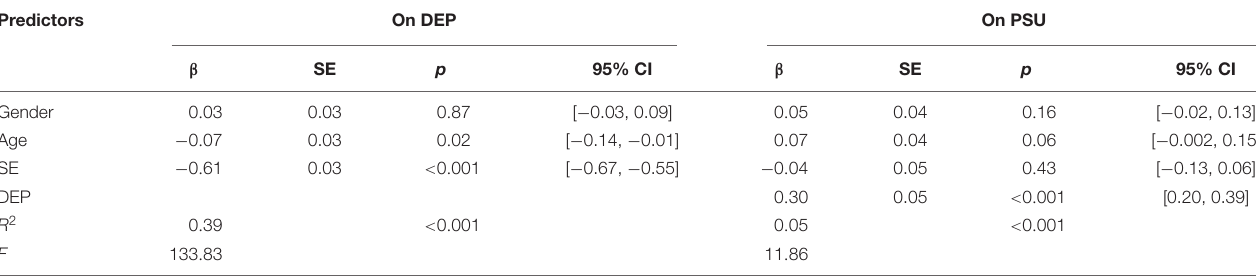
TABLE 2 | Testing the mediating effect of self-esteem on PSU. Predictors